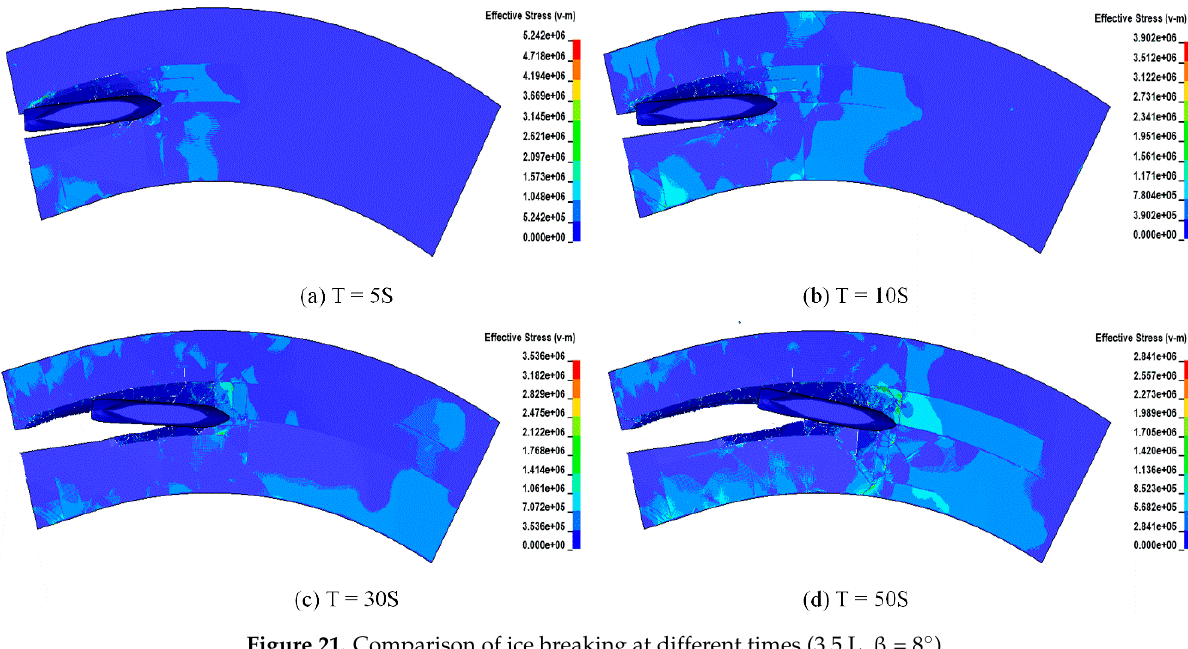
Figure 21. Comparison of ice breaking at different times (3.5 L, β = 8°).